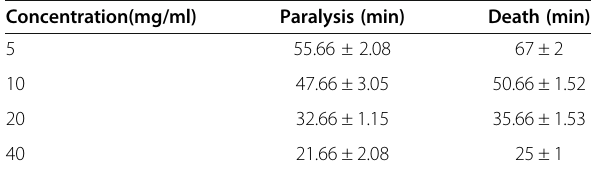
Table 2 Effect of extract in paralysis and death of